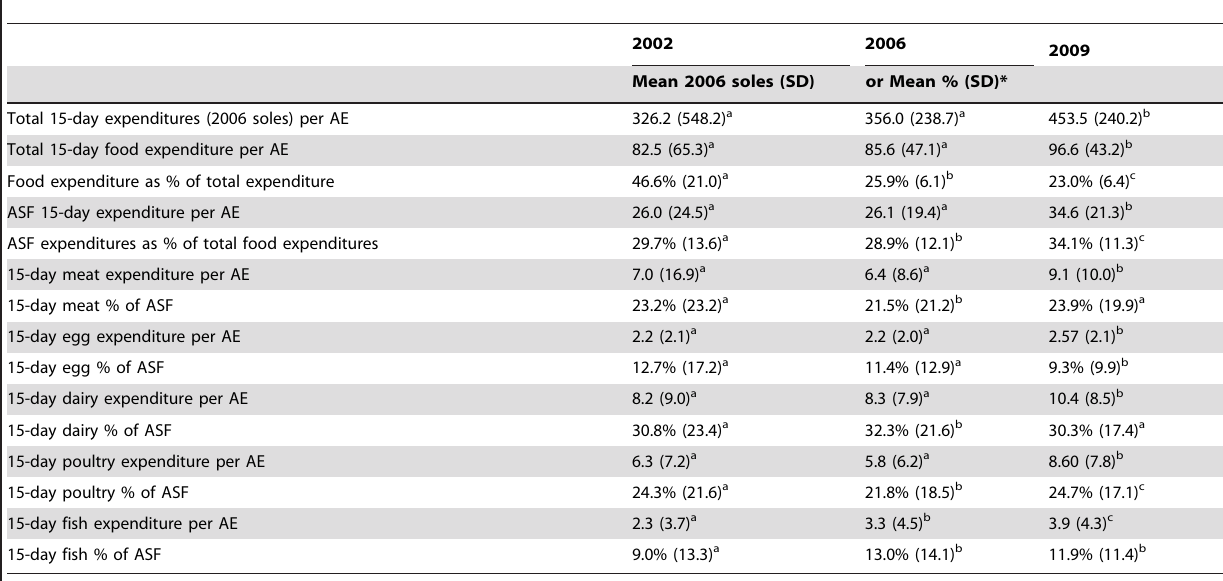
Table 1. Average Household Expenditures on Food and Groups of ASF per Adult Equivalent